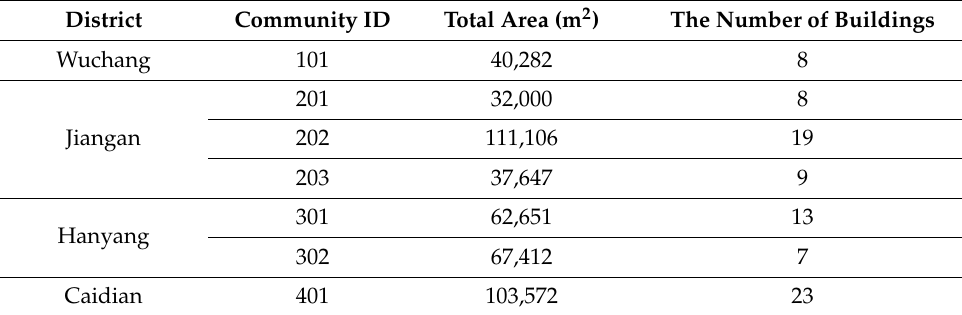
Figure 4. Districts in the city of Wuhan. Table 2. Add a descriptive label of the table here.